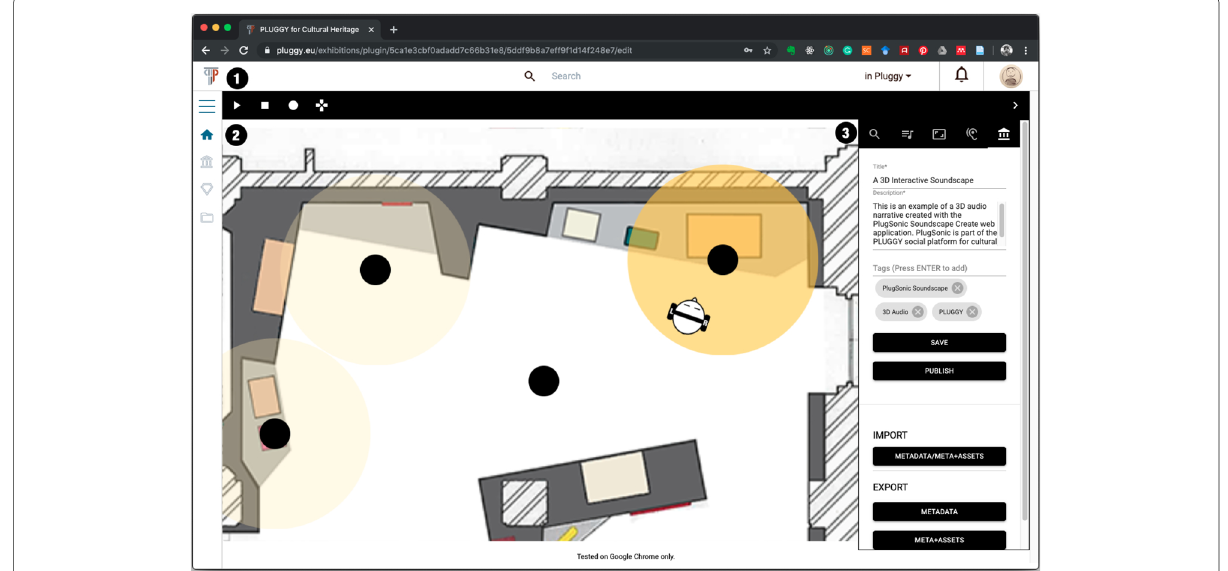
Fig. 4 PlugSonic Soundscape Create User